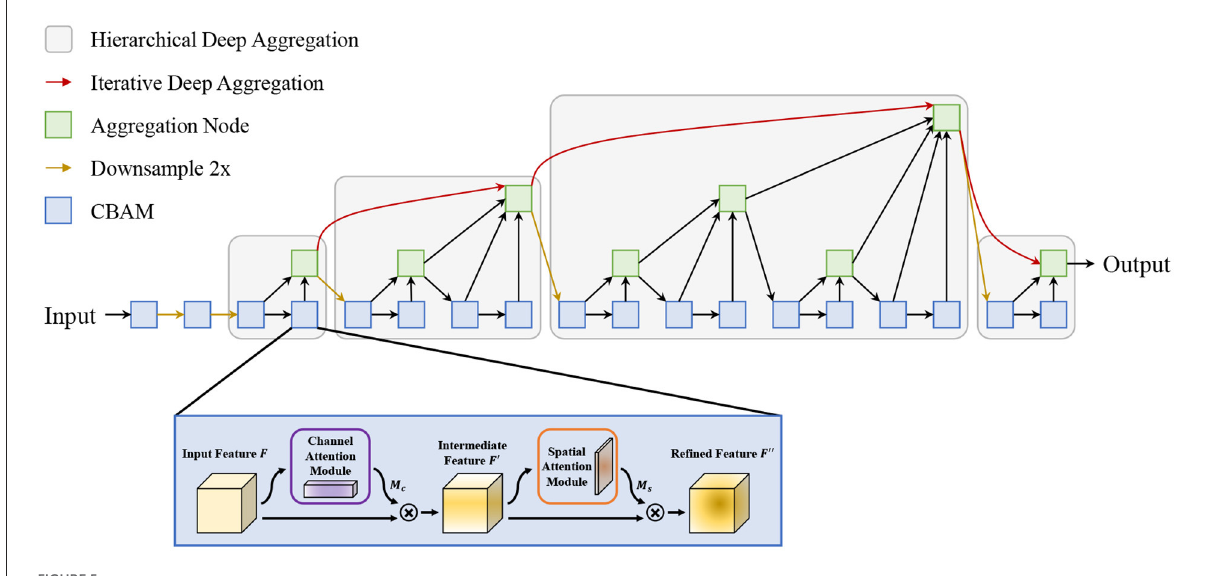
FIGURE5 The proposed attentive-DLA34